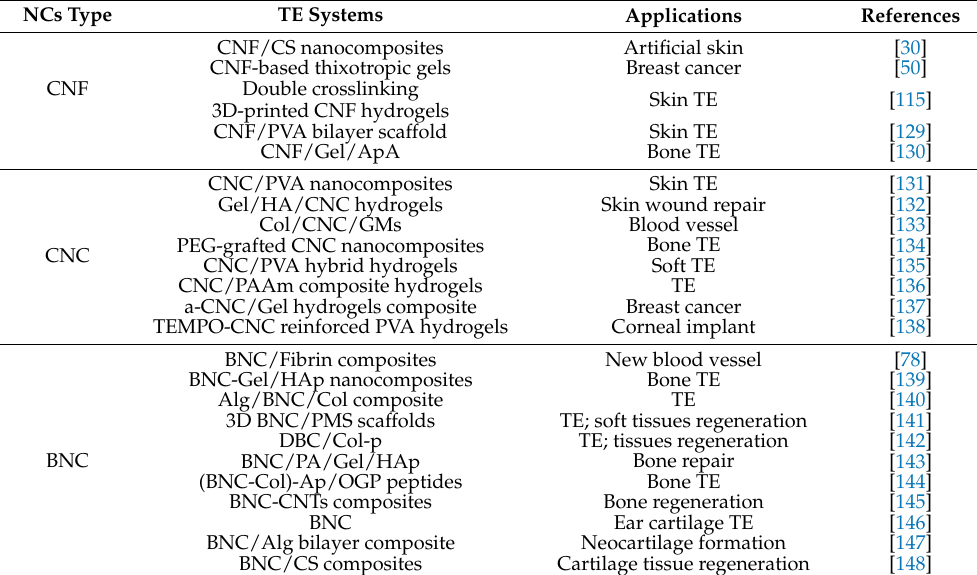
Table 3. Nanocellulose hydrogels/nanocomposites in tissue engineering